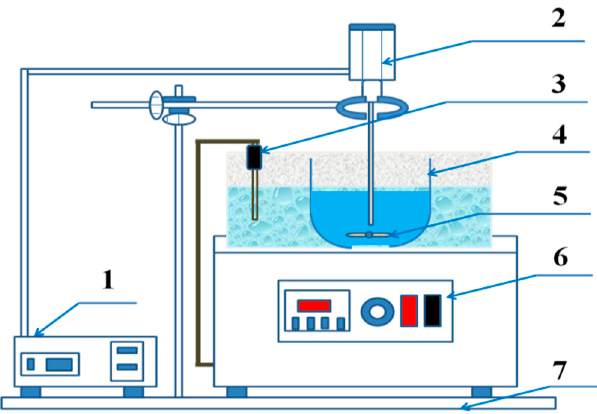
Figure 4. Connection diagram of experimental device (1 = ultrasonic generator console; 2 = ultrasonic radiation rod; 3 = thermocouple; 4 = beaker; 5 = magnetic rotor; 6 = water bath control panel; 7 = support frame).